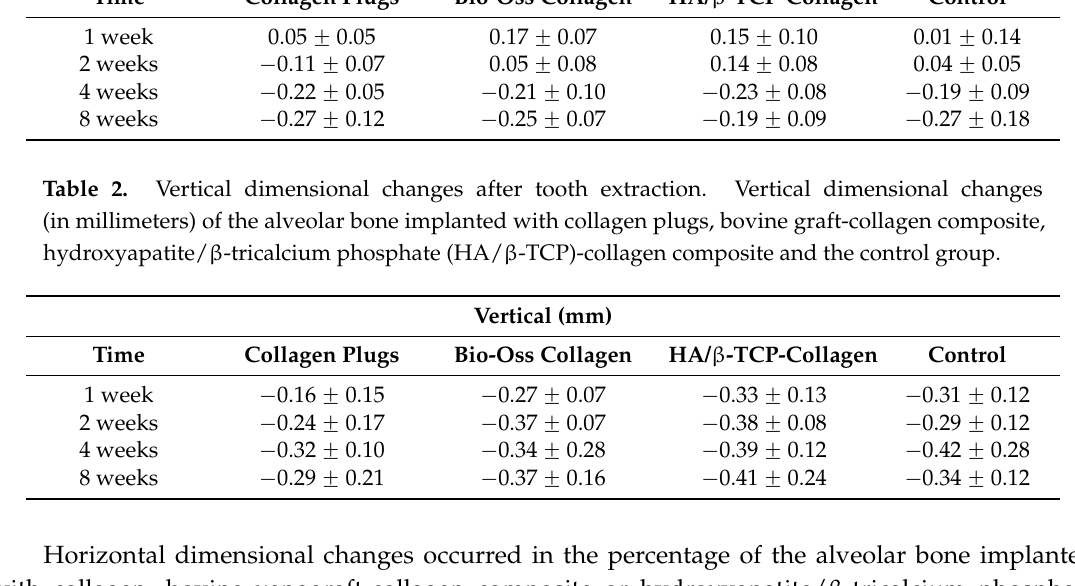
Table 1. Horizontal dimensional changes after tooth extraction. Horizontal dimensional changes (in